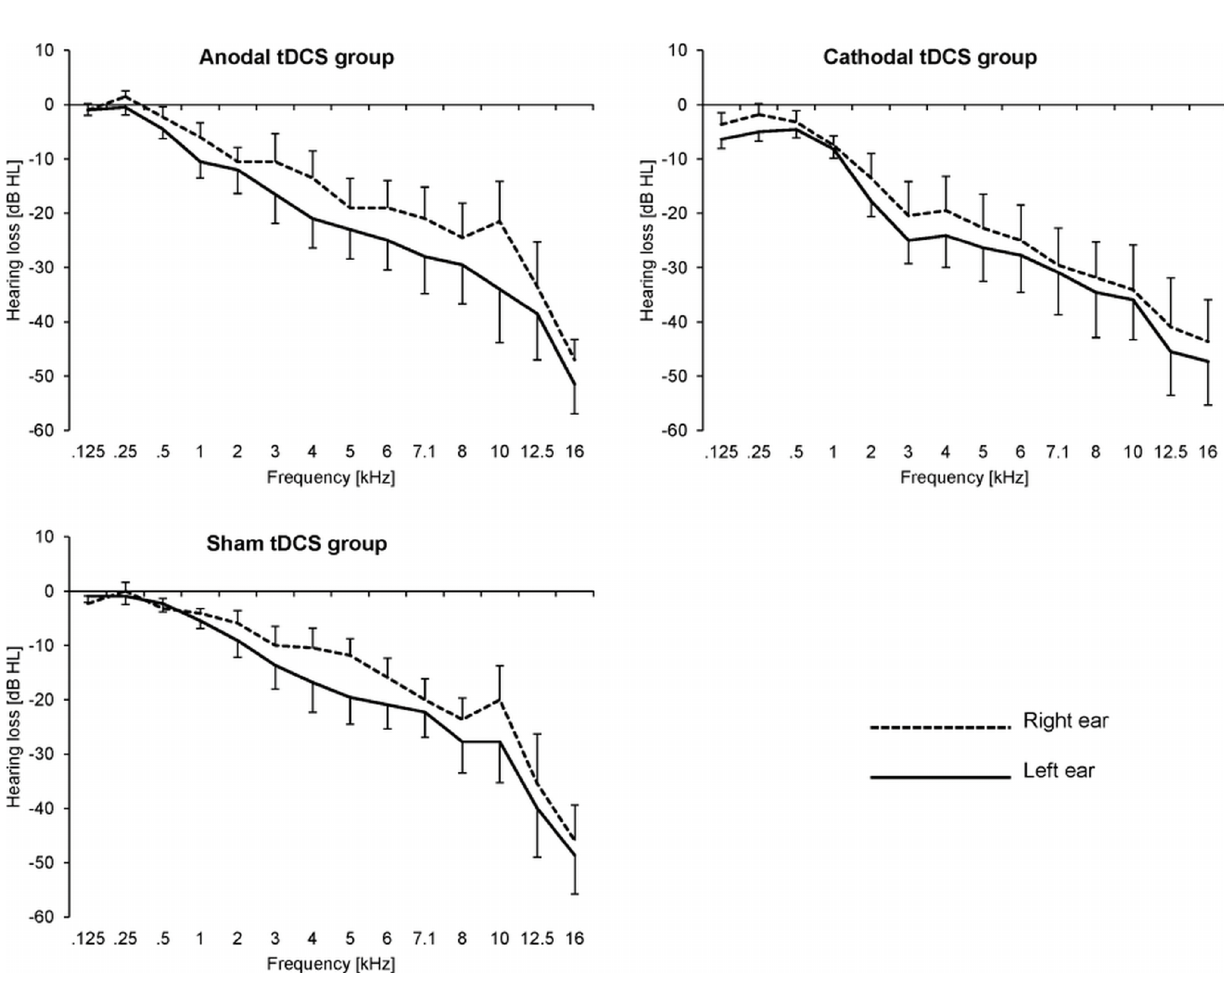
Figure 2. Average hearing thresholds. Thresholds from 0.125 to 16 kHz as functions of transcranial direct current stimulation (tDCS) condition (anodal group vs. cathodal group vs. sham group) and ear (left vs. right). The error bars denote standard error of the mean. Negative values reflect hearing loss. doi:10.1371/journal.pone.0089904.g002 PLOS ONE |